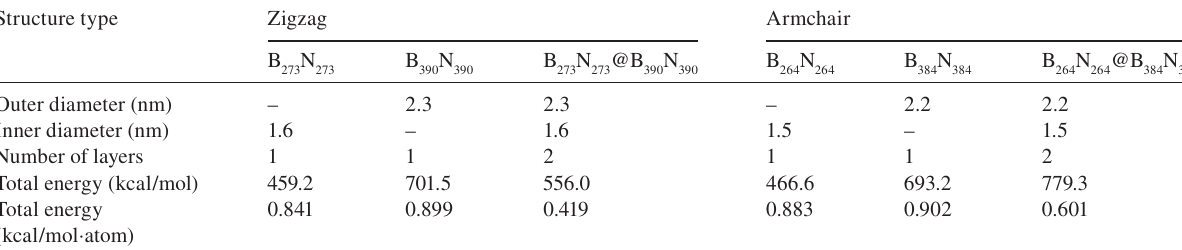
Table 6 Calculated values for various BN nanotubes.